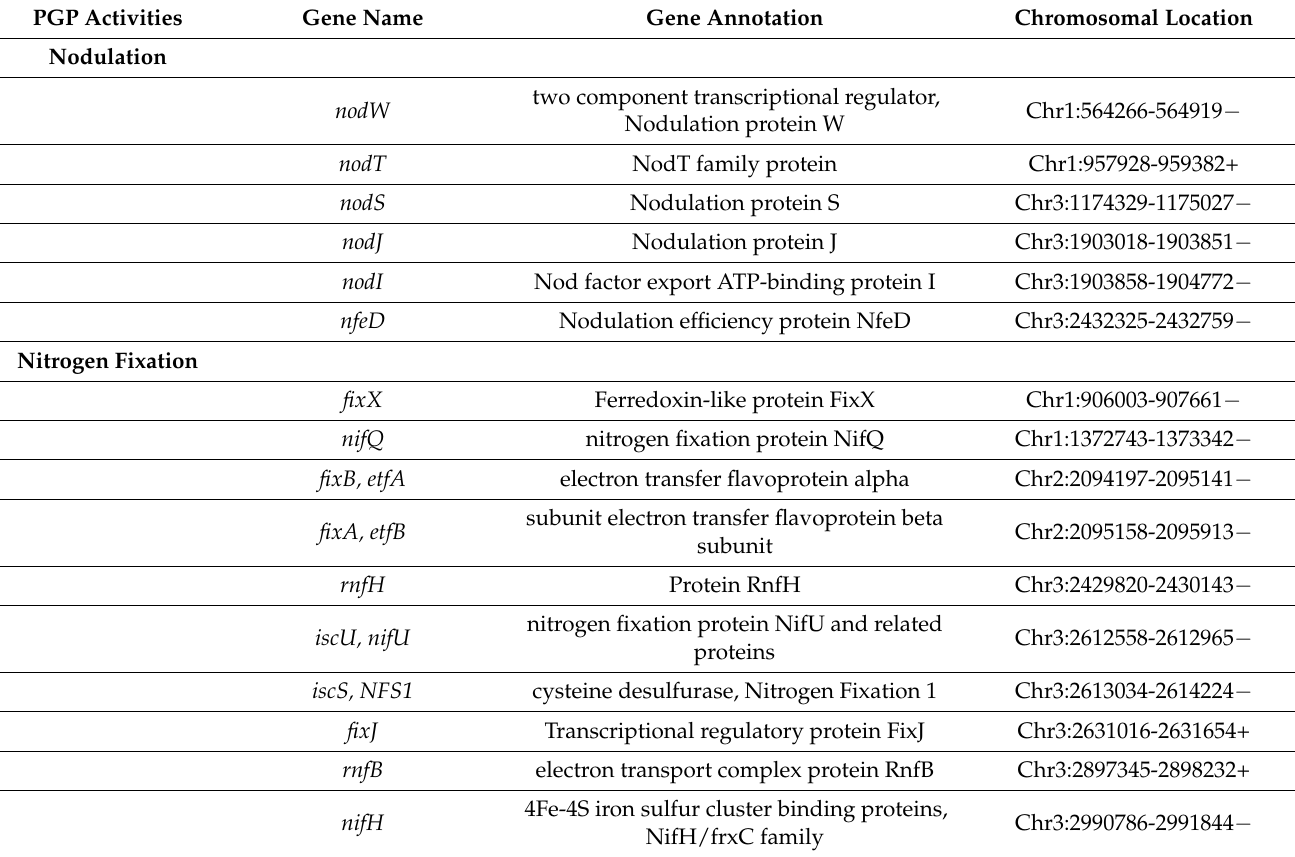
Table 1. Genes linked to nodulation and nitrogen fixation in BRDJ